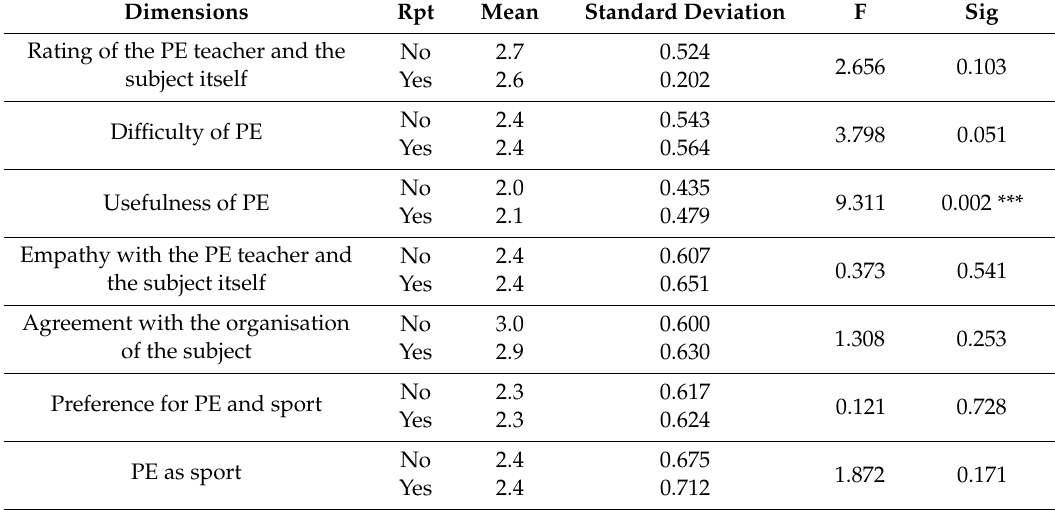
Table 4. Relation between dimensions of repeater and attitudes towards Physical Education.